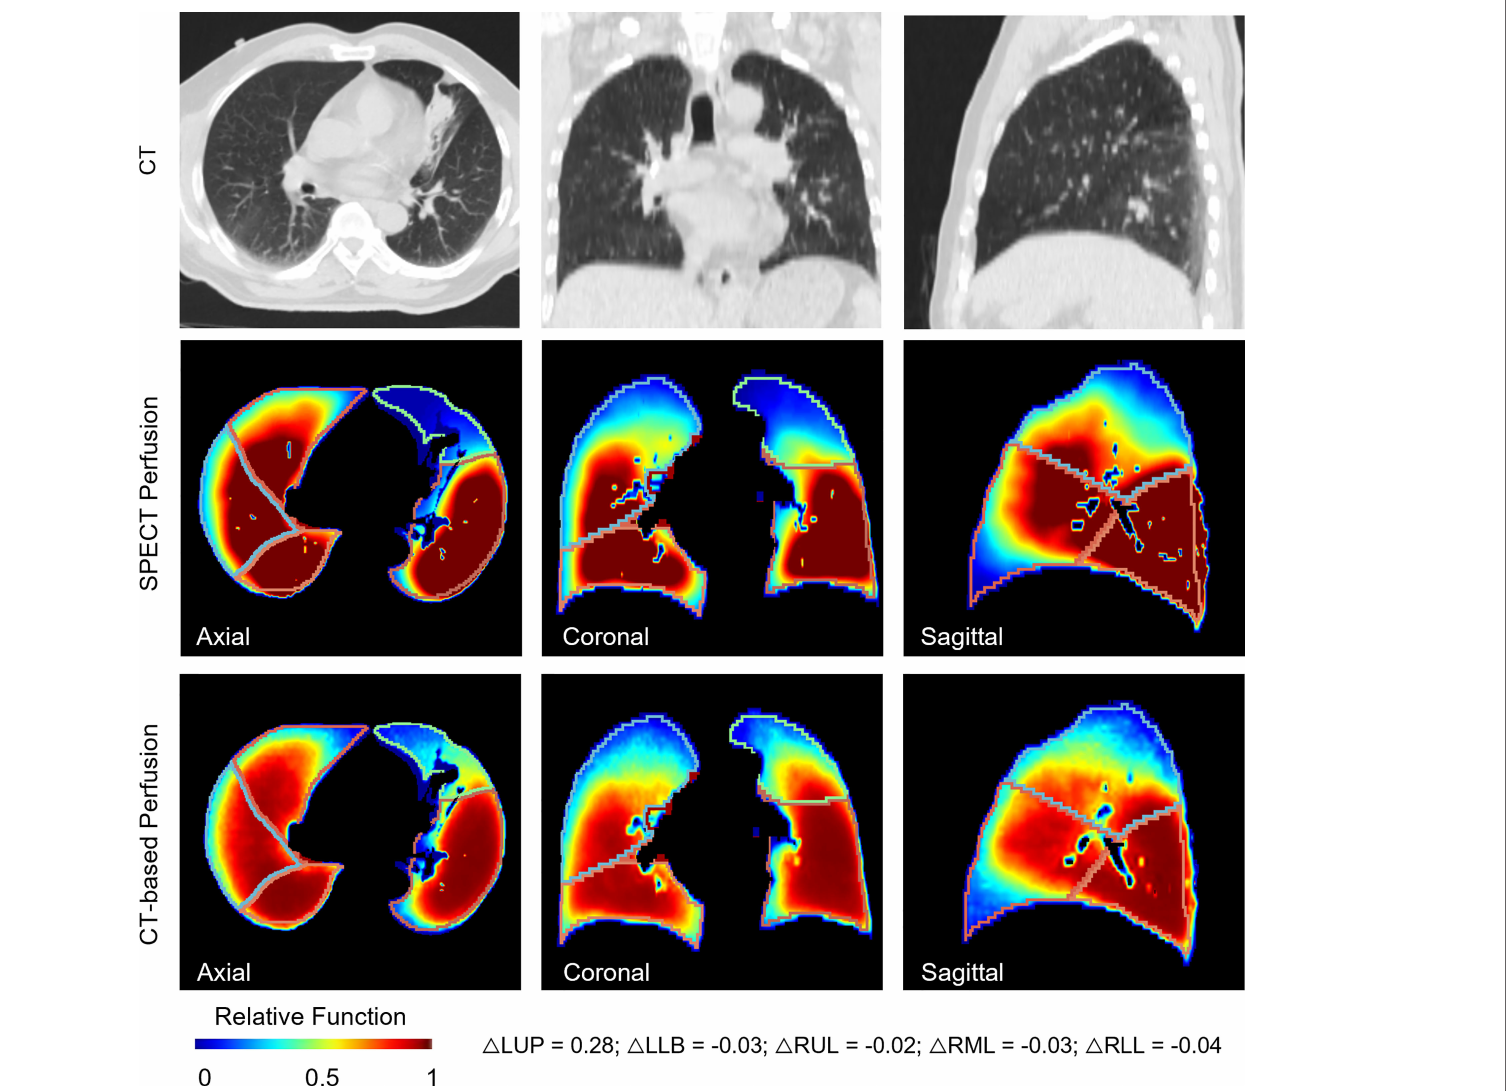
FIGURE 5 | A representative case for the lobe-wise agreement between the CT-based perfusion images and the ground-truth SPECT perfusion images. It shows a representative case of lobe-wise comparison of SPECT perfusion image and CT-based perfusion image. The difference in the mean perfusion function on the LUL, LLL, RUL, RML, and RLL were 0.28, -0.03, 0.02, 0.03, and -0.04, respectively. The LUL had the lowest perfusion values on both perfusion images. For the LUL, the mean perfusion value of CT-based perfusion images was 0.44, while it was 0.15 in SPECT perfusion images. For other lung lobes, the differences between the synthesized/ground truth perfusion images were less than